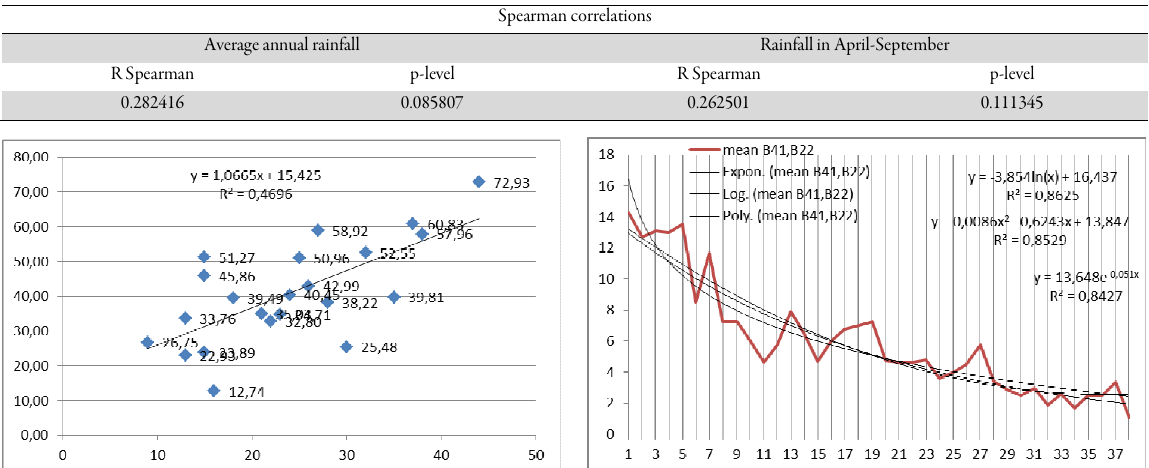
Table 3. Spearman correlations between growth indices and sum of annual rainfall, namely over the vegetation season April-September